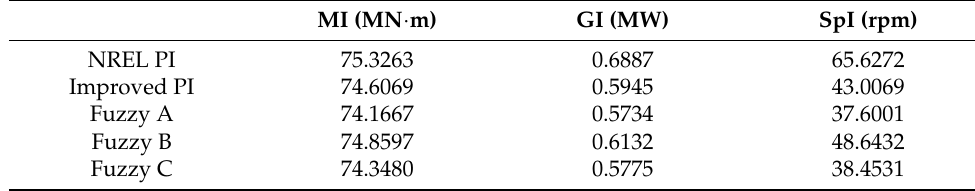
Table 8. Indexes for simulations with wind profile 2 (15 m/s